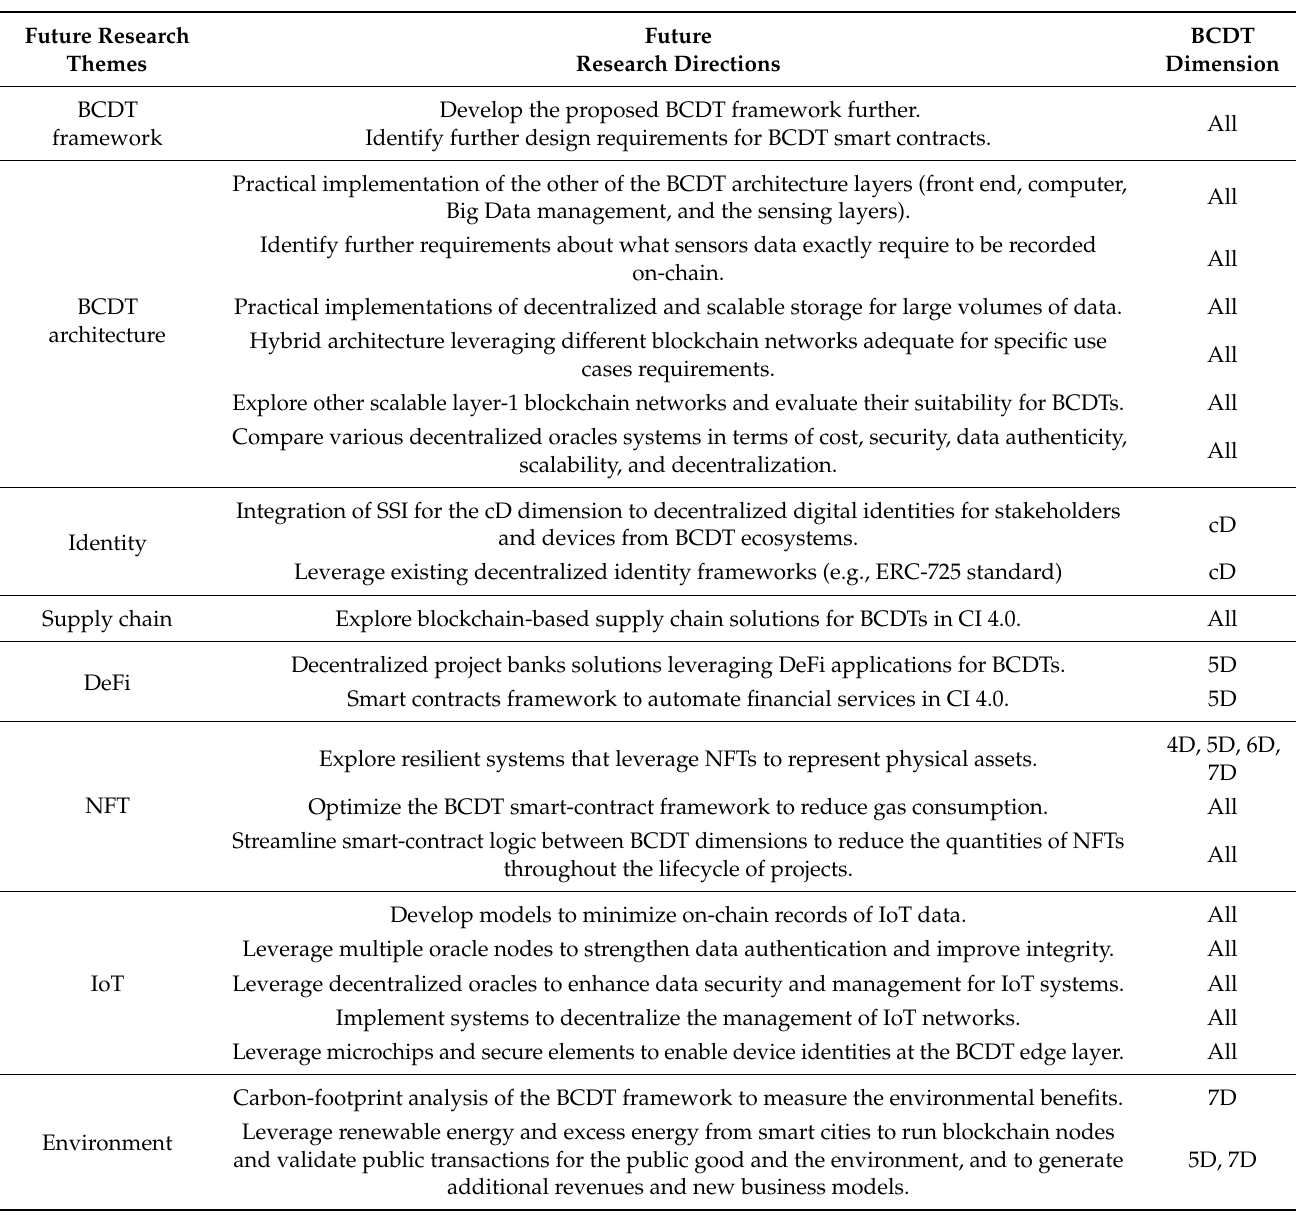
Table 8. Summary of future directions for research